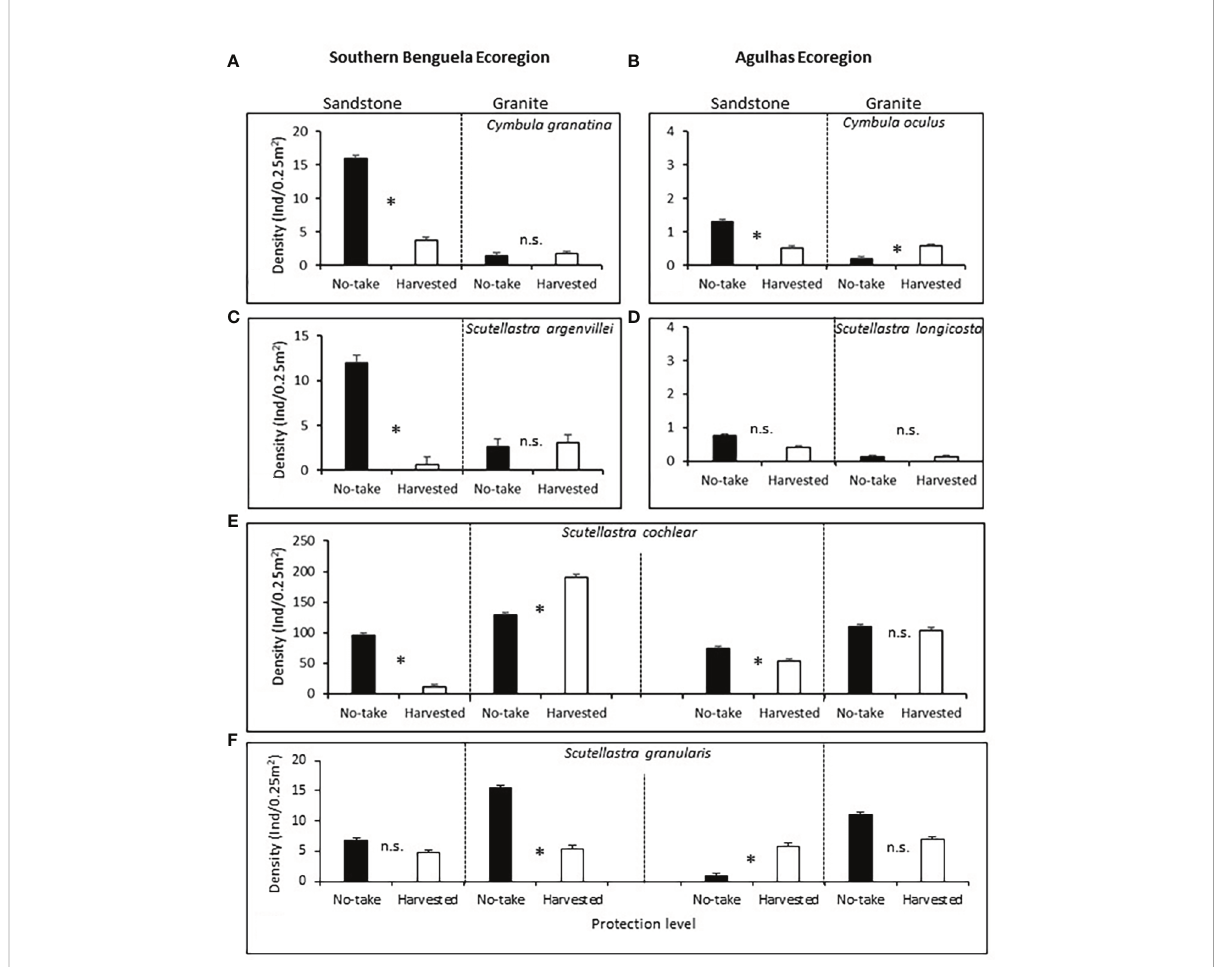
FIGURE 3 Mean densities (+1SE) of the frequently harvested limpets (A) Cymbula granatina , (B) C oculus and (C) Scutellastra argenvillei , and the rarely harvested limpets (D) S. longicosta , (E) S. cochlear and (F) S. granularis , with regard to protection level and rock type. The fi rst four species (A-D) occur predominantly in only one ecoregion, so this factor was not included for their analyses, but was included in the analyses for the fi fth and sixth species), which occur in both ecoregions. Ind, individuals. Asterisks between bars, Bonferroni-corrected signi fi cant differences; n.s., non signi fi